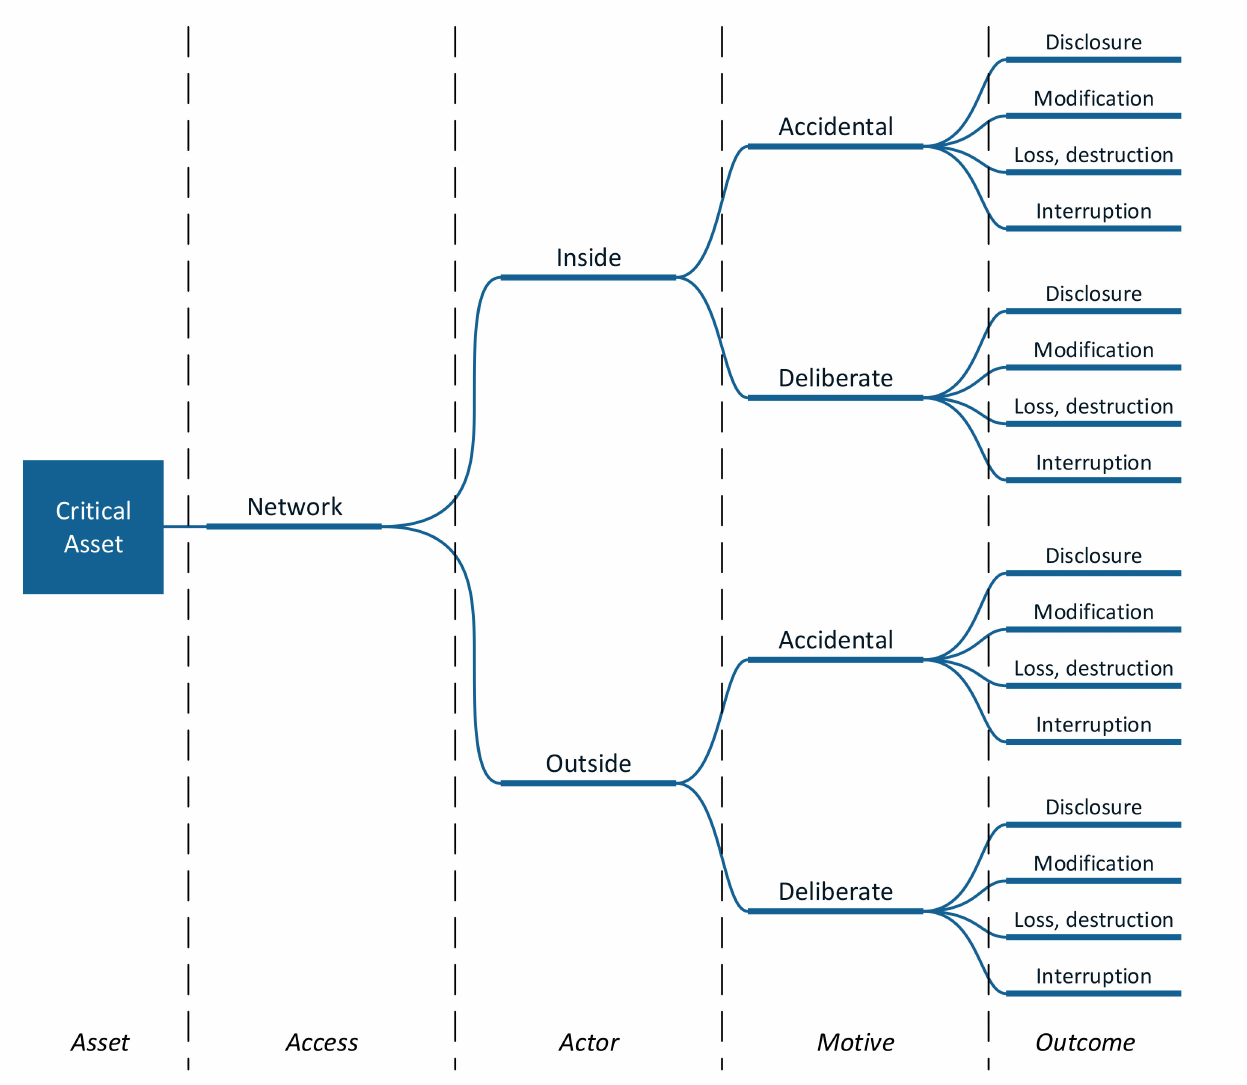
Figure 3. The variant tree is used to describe the profile in the OCTAVE